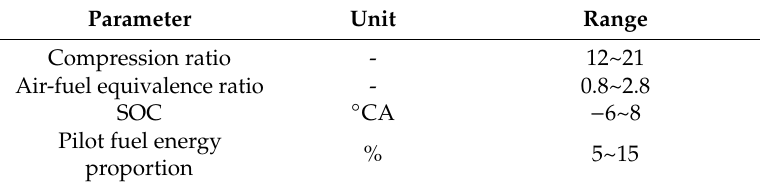
Figure 7. Ignition timing effect on engine performance and knocking parameters (Engine A). Table 9. Parametric settings for the knocking performance analysis of the Engine